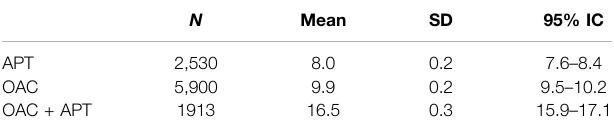
TABLE 2 | Time to treatment initiation from discharge a in a cohort of patients with atrial fi brillation who survived a stroke, by treatment strategy (secondary